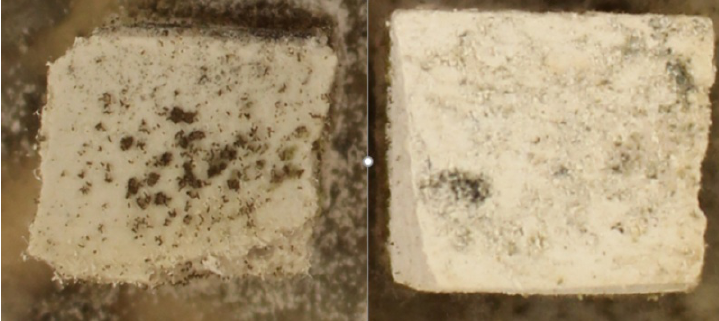
Figure 7. Sample 6 (left) and sample 7 (right) after 41 days.